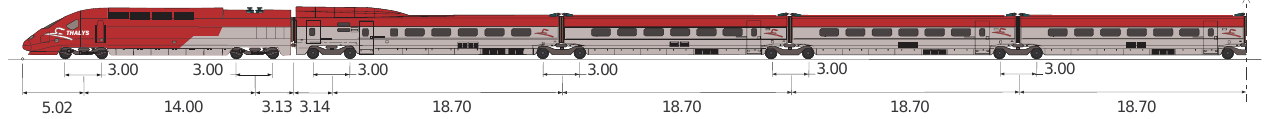
7 Example: the Thalys high-speed